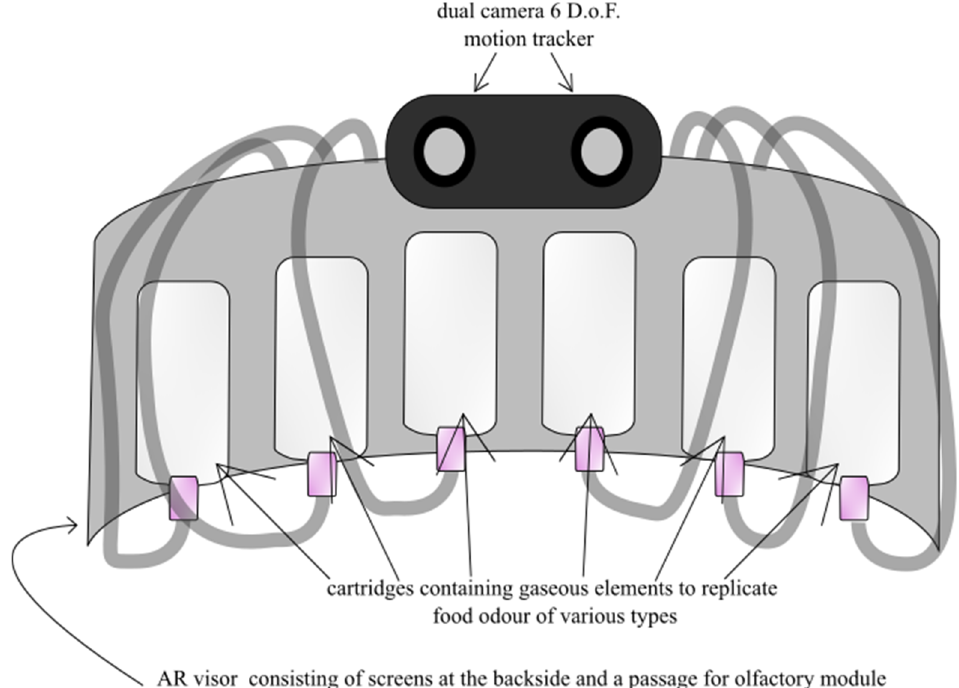
Figure 1. Architecture of the olfactory and gustation sensor module.